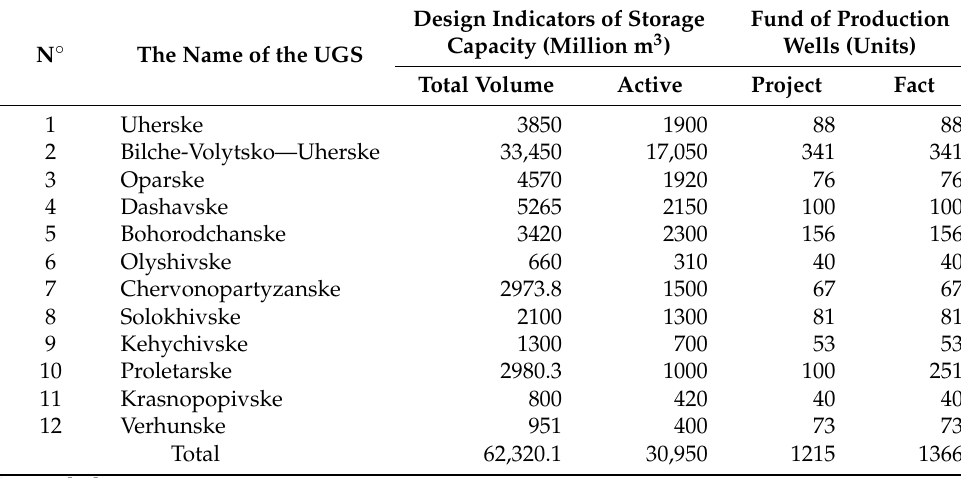
Table 4. UGS structure by capacity and fund of production